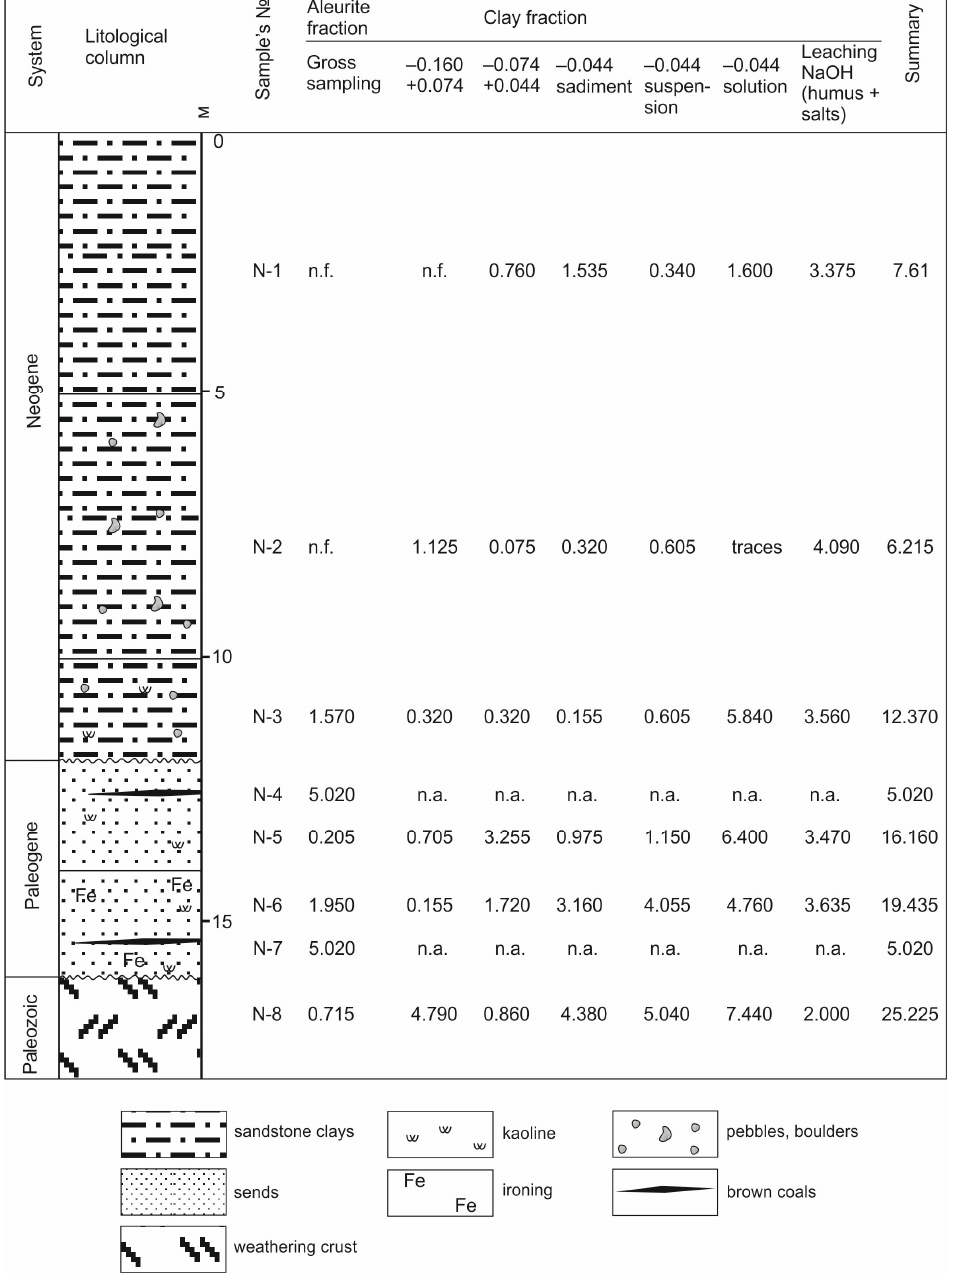
Figure 4. Gold distribution in the silty and clay fractions of the Nagiminskaya gold placer [23]. Abbreviations: n.f.—not found; n.a.—not analyzed; traces—trace